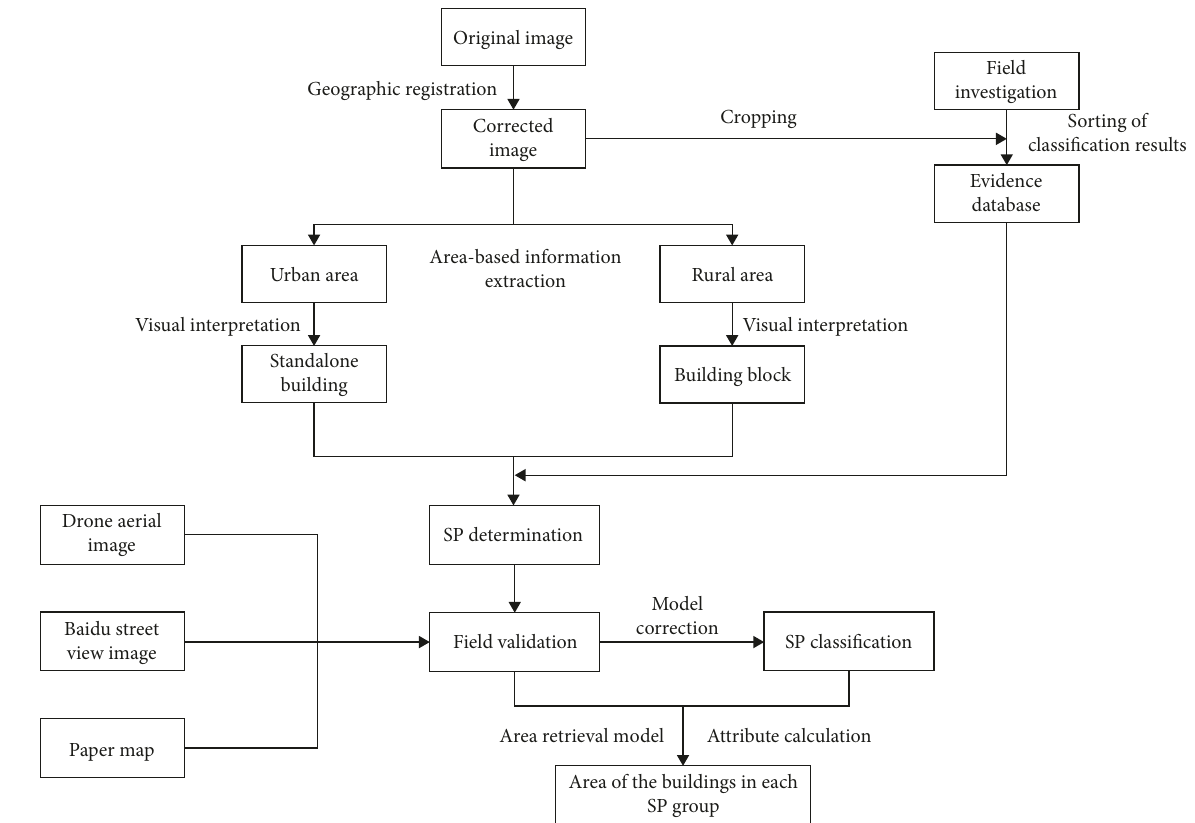
Figure 2: Flowchart of the method for visually interpreting the RS imagery and SP correction.